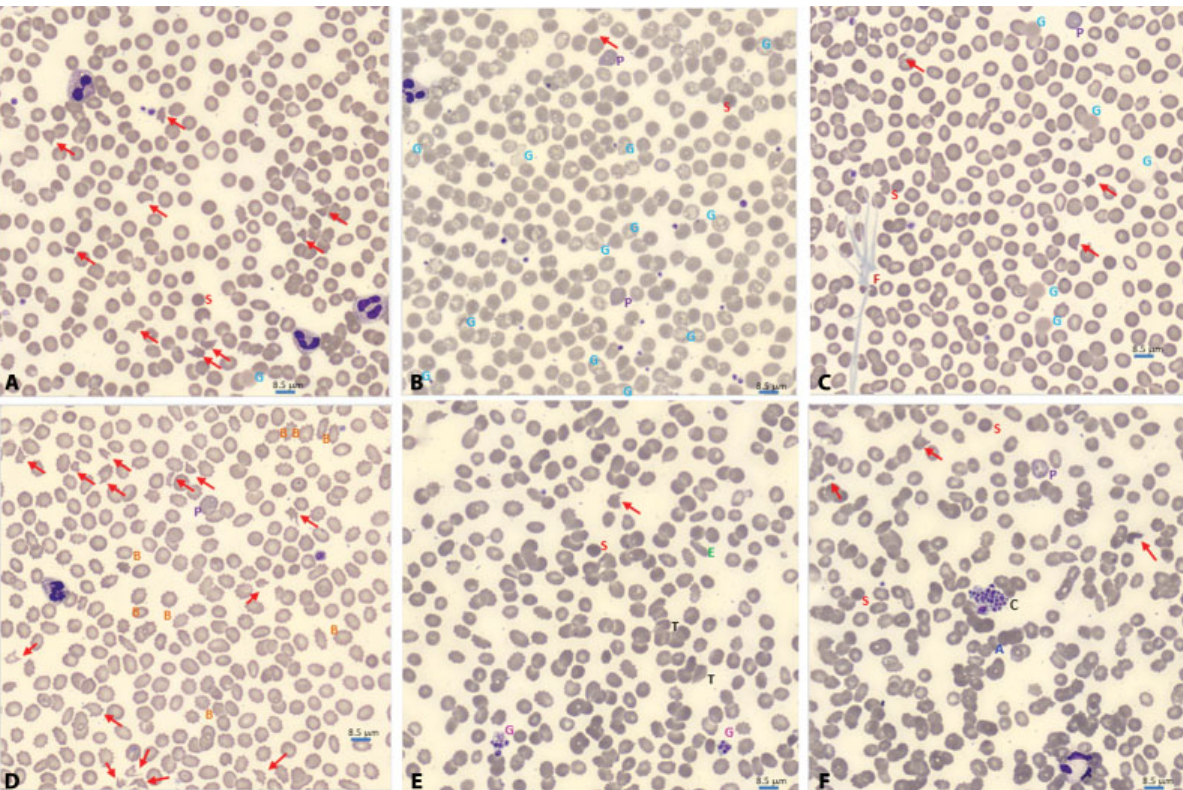
Fig. 2 Blood smear abnormalities in COVID-19. Morphology evaluation of peripheral blood smear was performed by reviewing digital images from CellaVision. Schistocytes/RBC fragments ( red arrow ) was a predominant fi nding in many COVID-19 patients. Spherocytes and micro- spherocytes ( red S ) were very abundant, especially in smears with high number of schistocytes, thus only one is pointed in each smear for illustration ( A – F ). Ghost red blood cells ( blue G ) was also a common fi nding. Several morphologies of ghost cells were seen: smudge and diffuse hemoglobin staining without intact membrane ( A and C ), vacuolated red blood cells with intact membrane, and vacuolated ghost without intact membrane ( B ). Polychromatophils ( purple P ) were also seen ( B, C, D, F ). Fibrin strands ( brown F ) were seen in several patients ( C ). Echinocytes, aka Burr cells ( orange B ), were seen in association with renal injury ( D ). Giant platelets ( pink G ) were seen in many COVID-19 patients ( E ). Elliptocytes ( green E ) and tear drops ( black T ) were seen in several smears ( E ). Platelet clumps ( black C ) andagglutination ( blue A ) were also seen in some COVID-19 patients ( F ). Scale bar ¼ 8.5µm. COVID-19, coronavirus disease